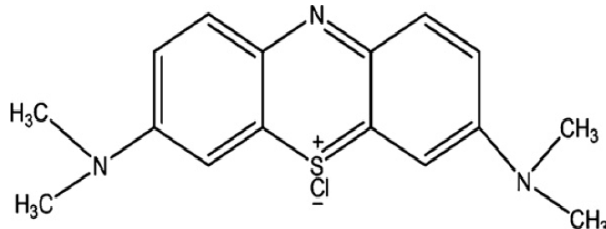
Figure 1. The structure of methylene